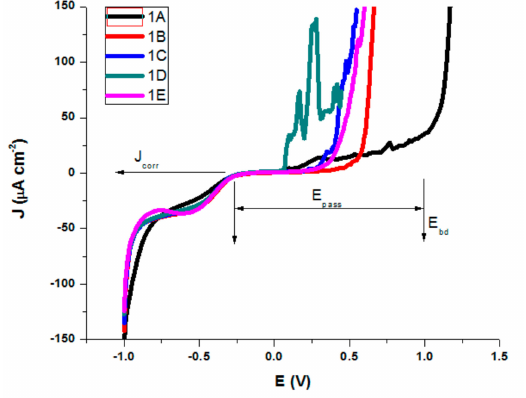
Figure 11. Polarization curves in NaCl 0.9% for AISI 316 modified stainless